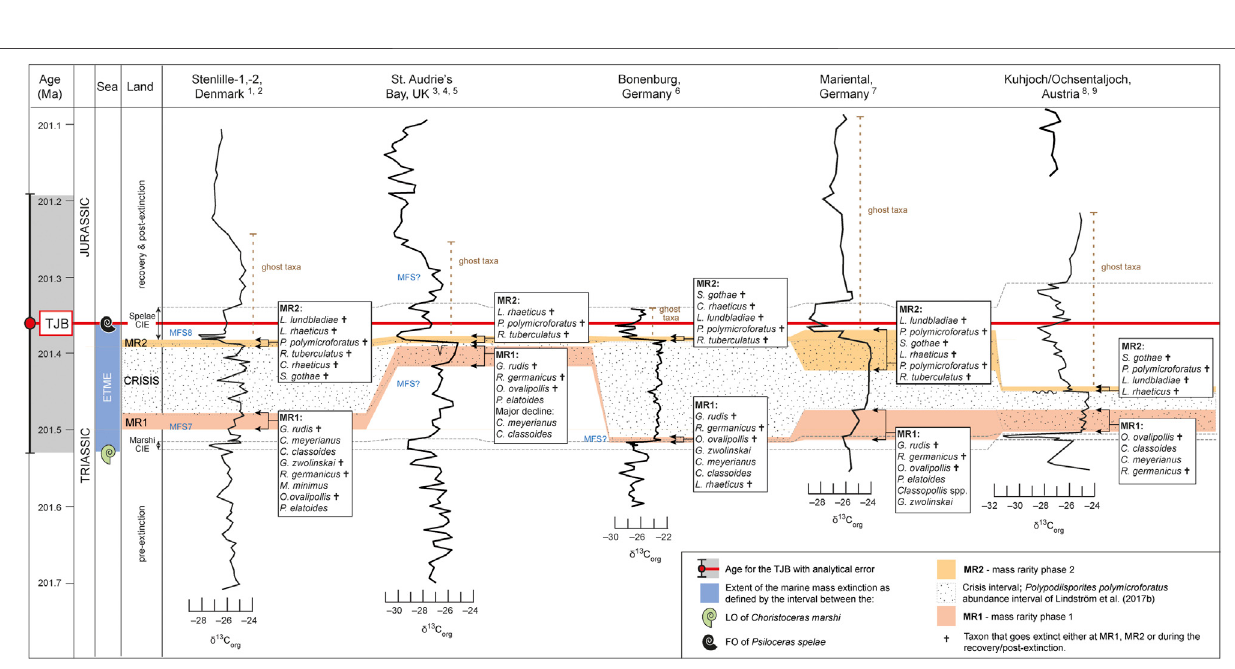
Frontiers in Earth Science |